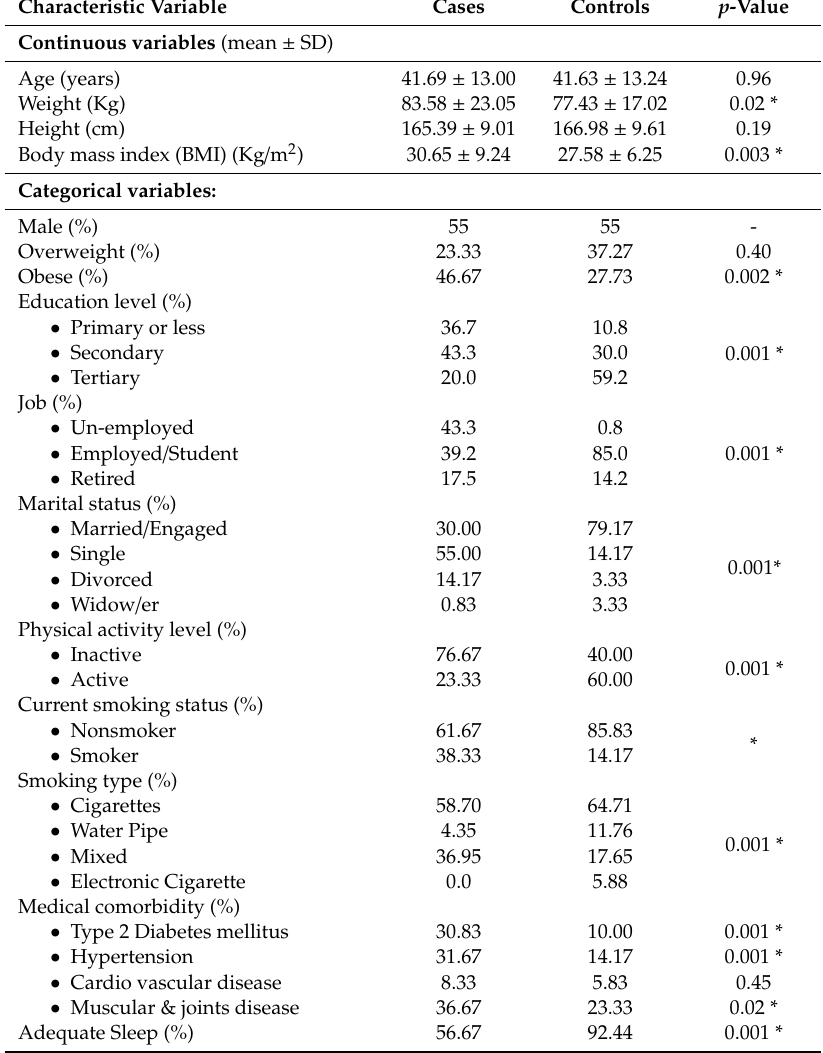
Table 1. Socio-demographic characteristics of schizophrenia cases and healthy